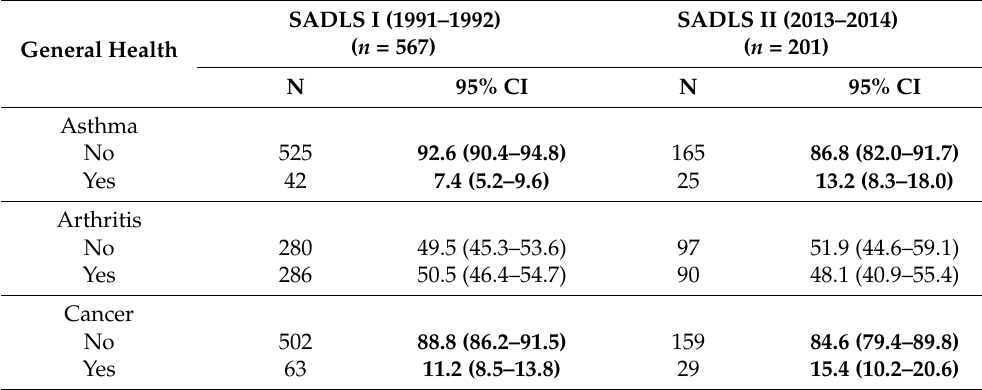
Table 3. Chronic diseases of two cohort of Australian older adults at